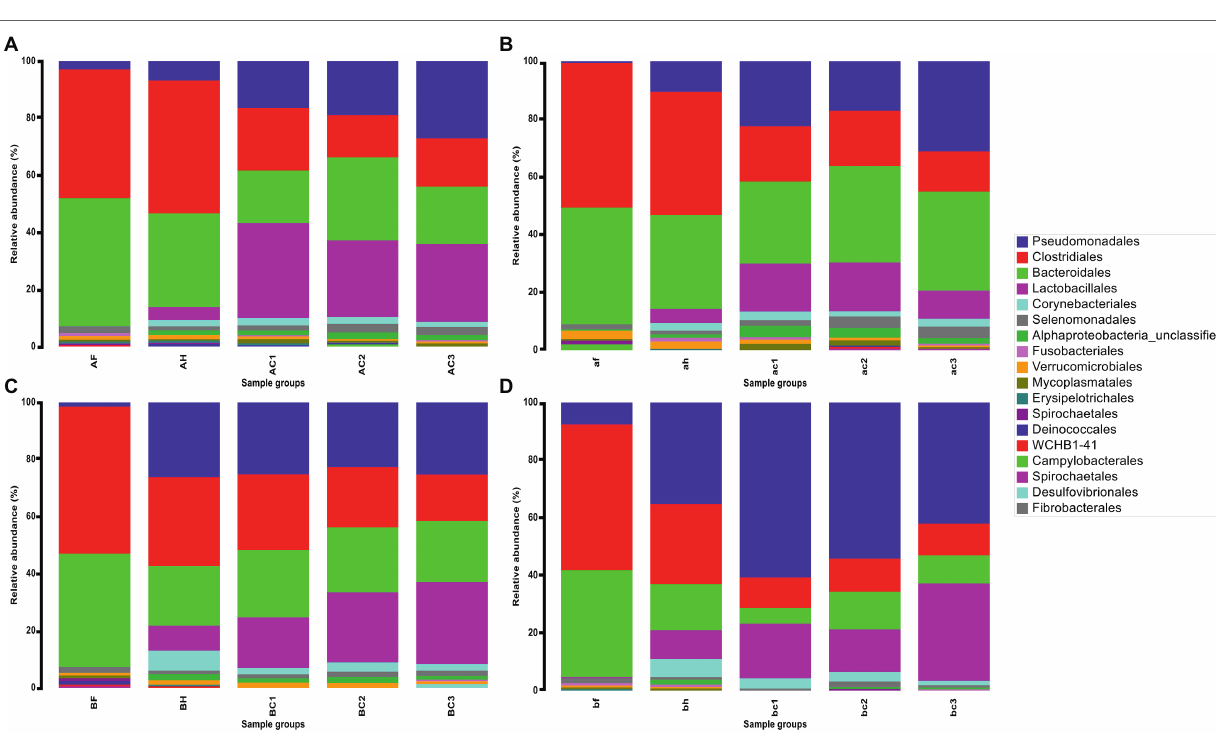
10% ( Figures 3A,B ). In abattoir B, Clostridiales (C: 29.9% and D: 27.0%) and Bacteroidales (C: 19.9% and D: 15.5%) were also predominant, but an increase in the presence of